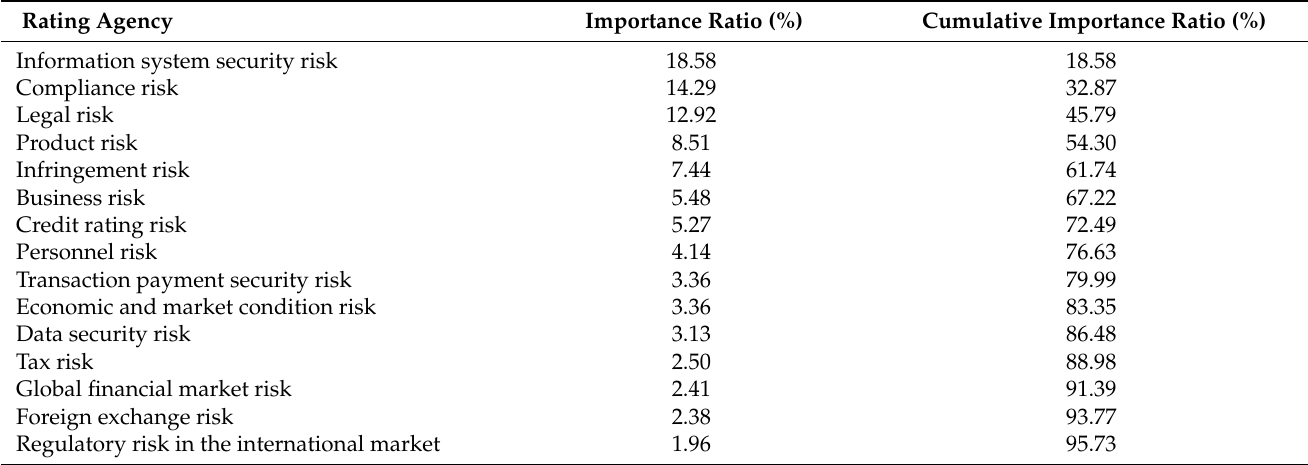
Table 9. The importance ratios of risks faced by the rating agency industry from 2015 to